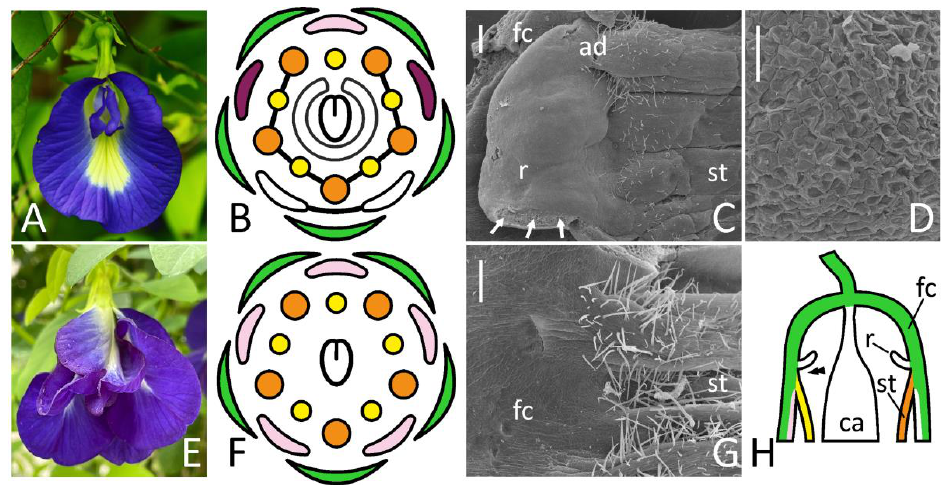
Figure 4. Floral morphology ( A , E ), floral diagrams ( B , F ) and SEM images of identical areas on a border between floral cup and androecium ( C , D , G ) in wild-type ( A – D ) and ‘double’ ( E – G ) flowers of Clitoria ternatea . The position of illustrated area in a resupinated flower is schematically represented on ( H ). A marginal part of ridge-like structure of wild-type flower is enlarged on ( D ). Key: arrows = rupture caused by the dissection; double arrowhead = place illustrated in ( C , G ); ad = adaxial side; ca = carpel; fc = floral cup; r = ridge; st = stamens [note absence of staminal fusion on ( F )]. For color designations on floral diagrams and ( H ), see Figure 1. Scale bars: 300 μm ( C , G ), 30 μm ( D ). Photos: Arturo C. Mendoza ( A ), Janardhan Uppada ( E ).